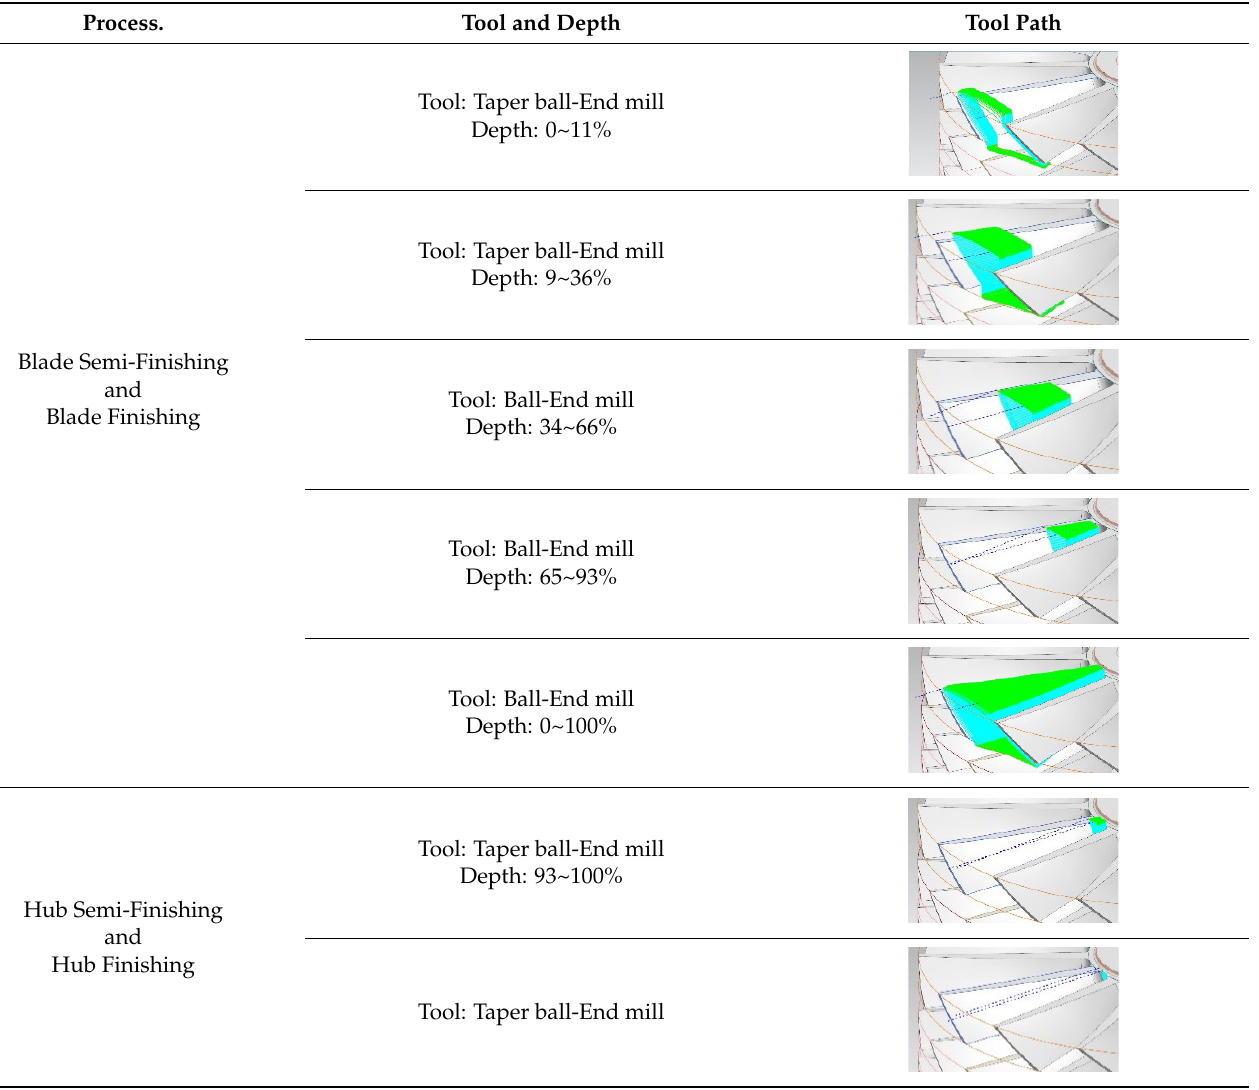
Hub semiroughing Hub semiroughing involved semiroughed grooving on the blade hub. Because the end mill in rough machining had shape limits and the cutting depth could not reach the hub of the blade, a ball nose end mill with an elongation of 110 mm was used to groove cut the workpiece during semiroughing. The cutting depth was 93–100% of the blade length, and the reserve was set at 0.3 mm. The spindle speed was 6000 rpm, the feed rate was 1200 mm/min, and the cutting depth was 0.1 mm.